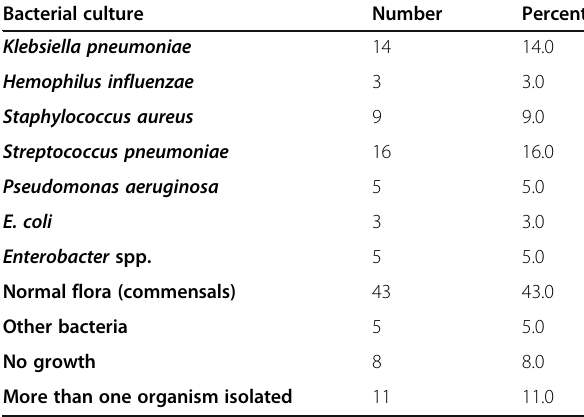
Table 1 Sociodemographic characteristics of studied cases